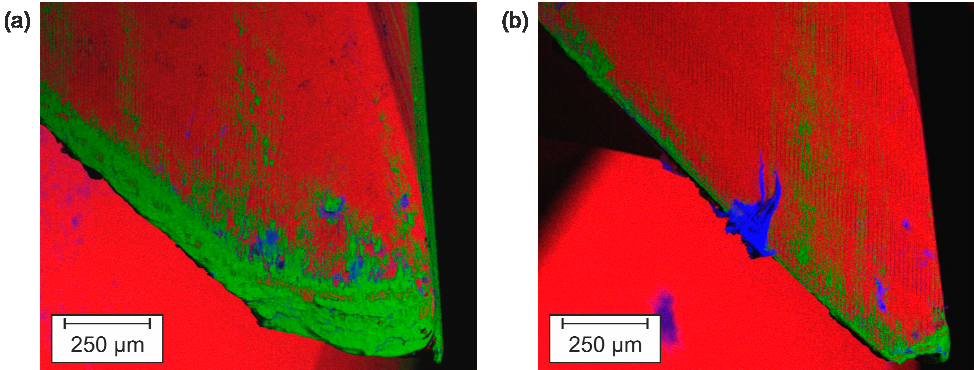
Figure 5. Elemental mappings showing the distribution of titanium on the tool in green after milling in ( a ) laboratory air and ( b ) an XHV-adequate environment (red: tungsten; blue: carbon).